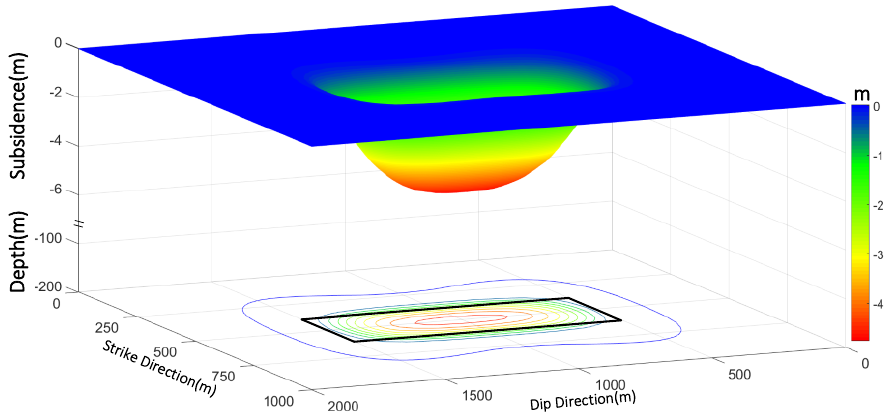
Figure 5. Simulated subsidence basin in 3D view. The black rectangle is the working face. The closed colorful curves are the projection of the subsidence contour on the horizontal plane of the working